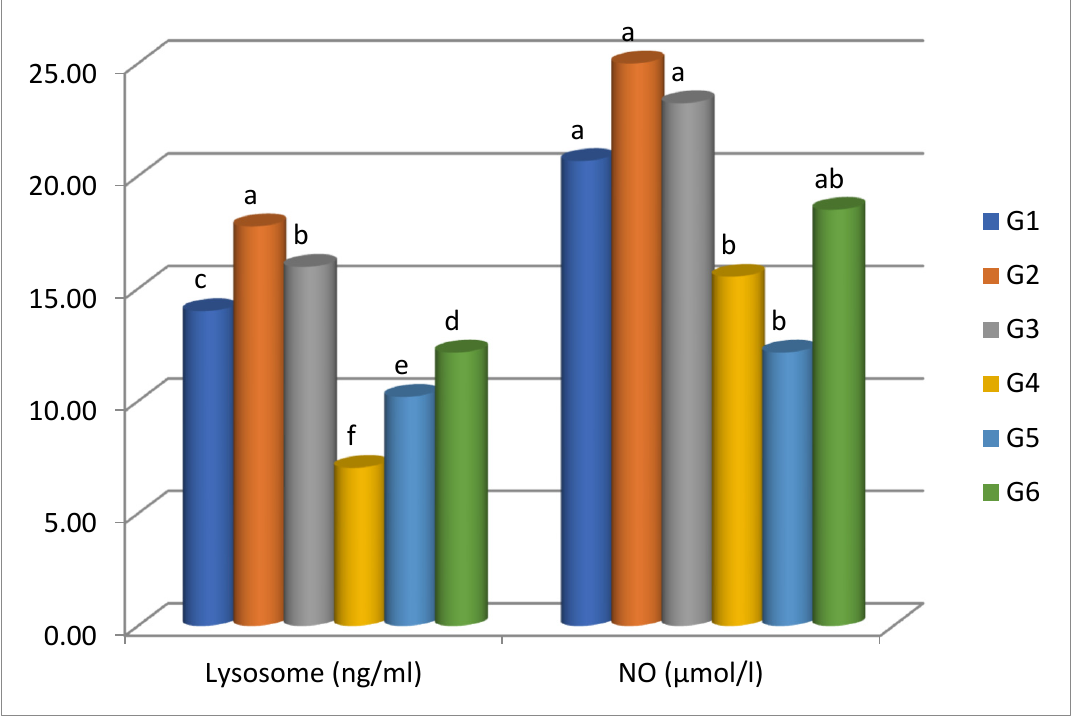
Figure 3. Lysozyme and serum nitric oxide activities of Nile tilapia fed supplemented diets in formic acid and carvacrol post-challenge with P. putida . Bars represent the arithmetic mean; error bars are SD. Different letters indicate significant differences ( p < 0.05, Tukey’s multiple comparison tests) among groups.